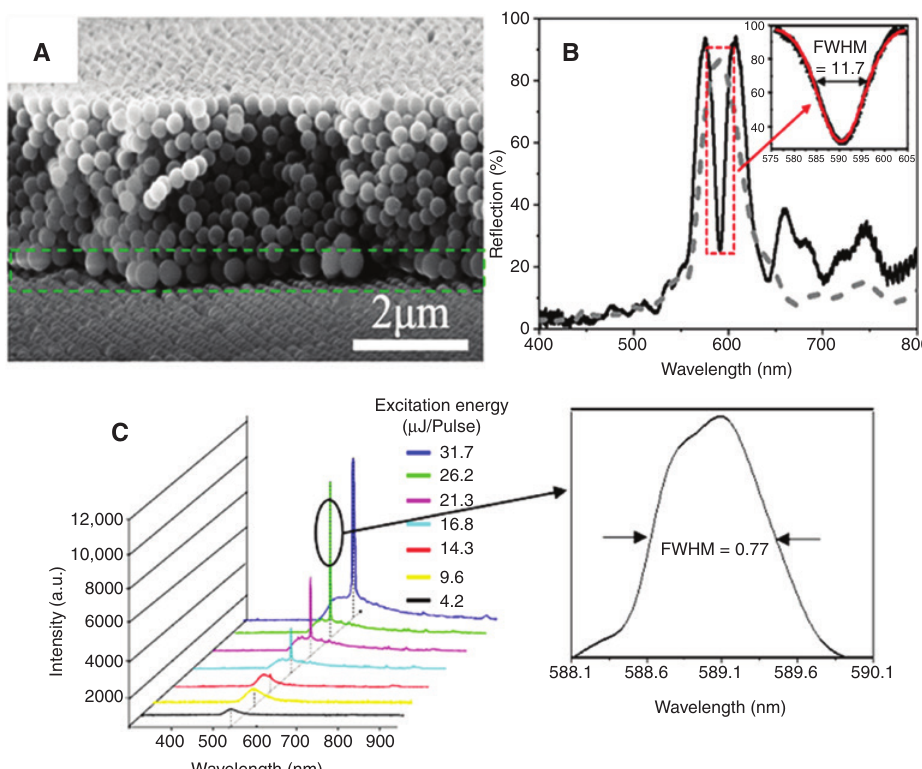
Figure 6: Defect mode passband lasing in sandwich-like CPCs. (A) A typical SEM cross-section view of the obtained sandwiched CPCs with a defect layer as indicated by green lines. (B) The optical proper- ties of the CPCs with (black solid line) and without (grey dashed line) a defect layer. (C) Emission spectra obtained from the sandwiched CPCs with various excitation energy. Adapted with permission from ref. [149], COPYRIGHT 2016 American Chemical